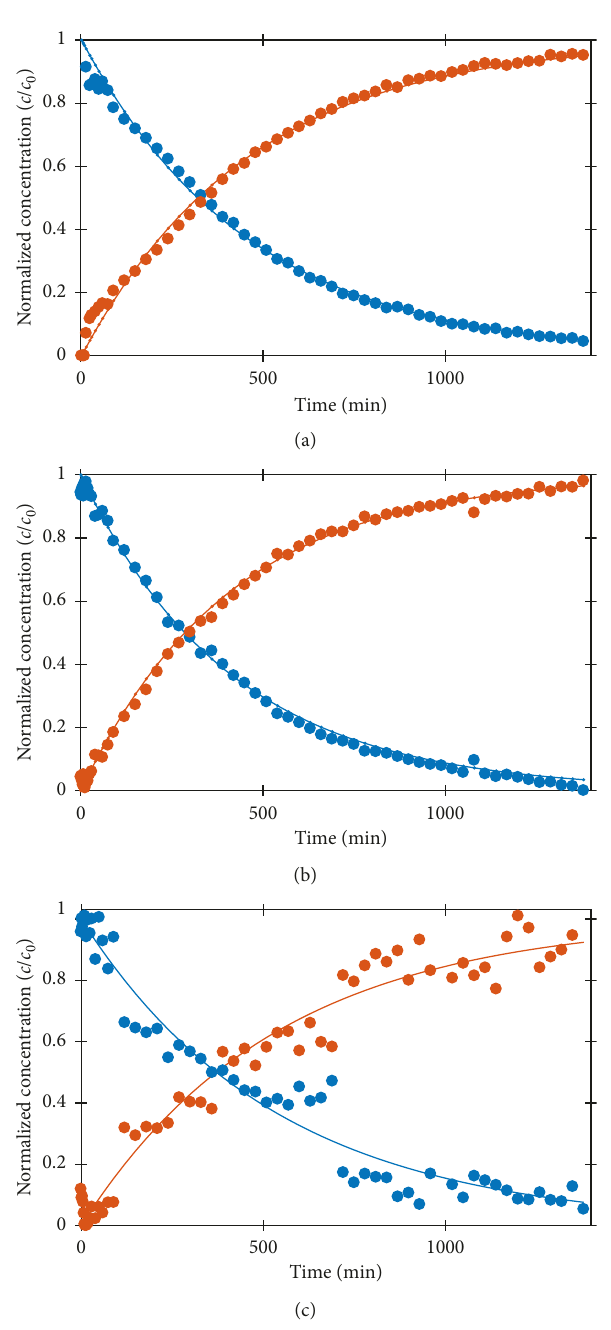
Figure 6: c-t profiles from MCR-ALS modelling for the enzyme- catalysed hydrolysis of acetic anhydride to acetic acid in the Ehrfeld microreaction system. Results on the basis of the 1 H NMR (a), Raman (b), and NIR (c) data. The computed data fits correspond to first-order reaction A ⟶ B (orange and blue lines), and the points are extracted data for product (red) and educt